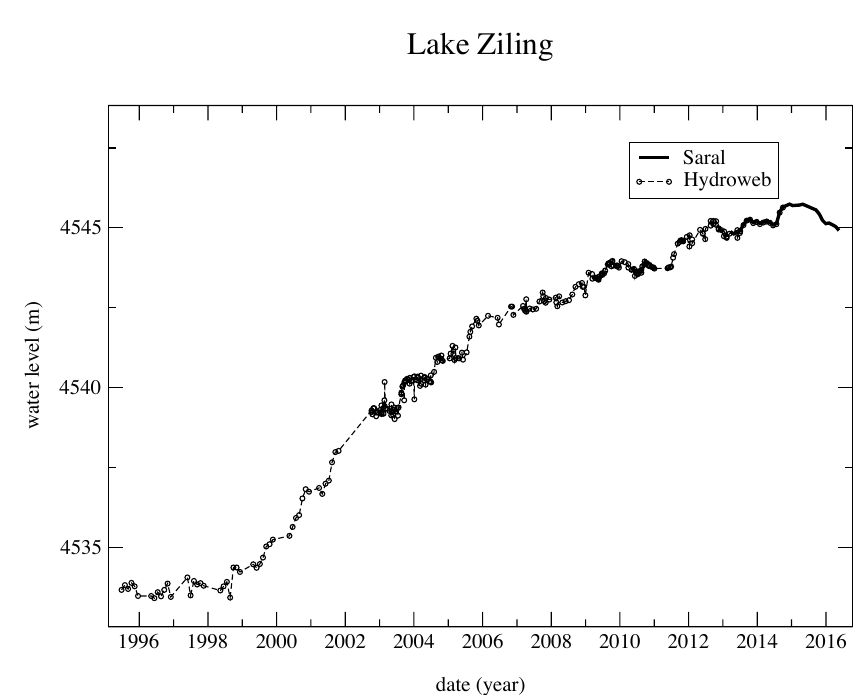
Figure 19. Water level change of the Ziling Lake from a multi-satellite data processing after removing the inter-satellite biases. After a long period of increasing starting in 1999, the lake level has stabilized in 2013/2014 (extracted from Hydroweb database http://hydroweb.theia-land.fr/ and from SARAL/AltiKa data processing for the period 2013–2016).